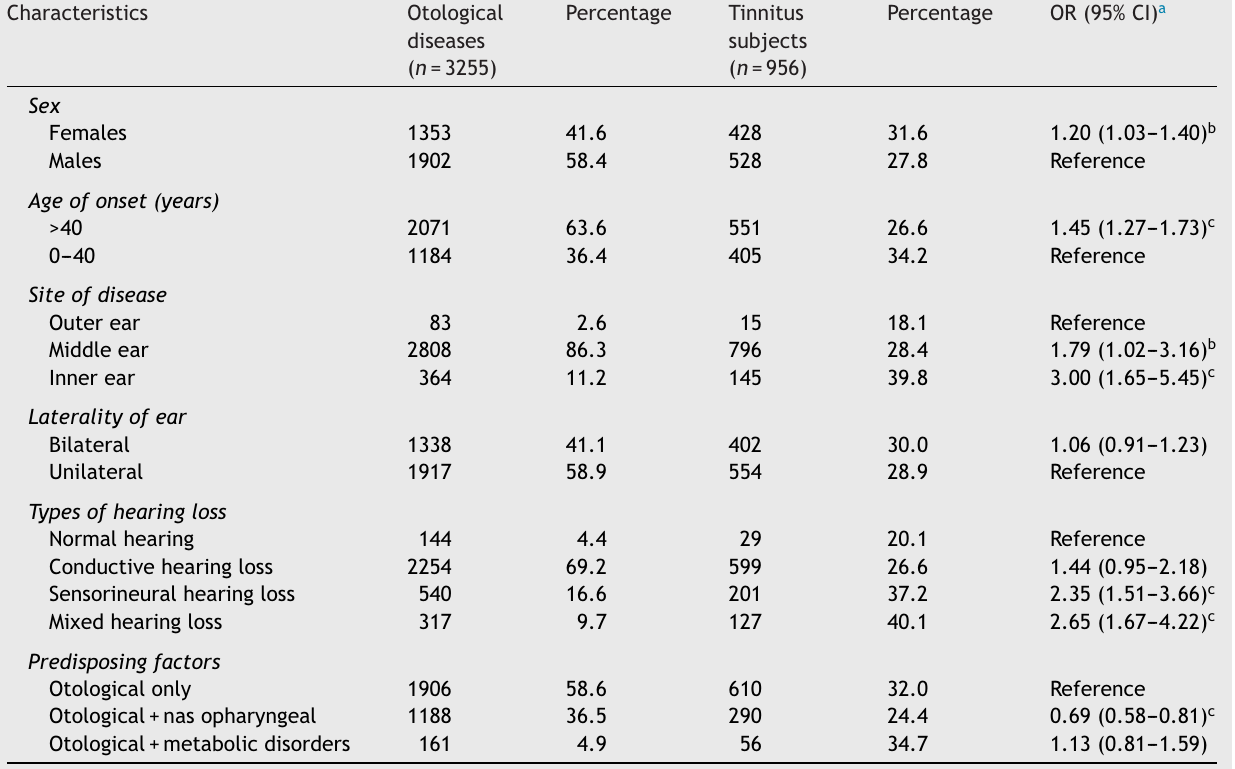
Clinical and demographic findings in subjects affected with tinnitus among otological disorders.